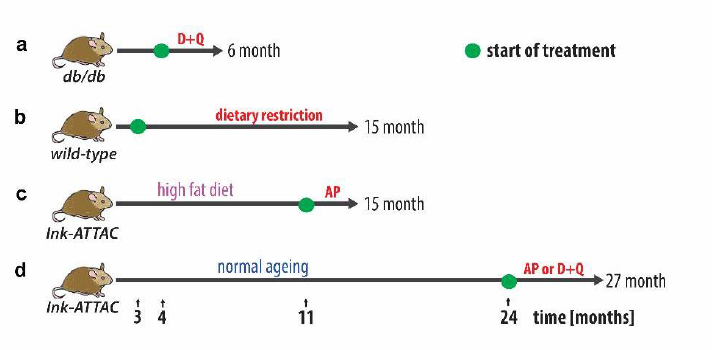
Figure 1: Treatment scheme for obese and ageing animals. (A) db/db mice were treated with D+Q for 2 months until 6 months of age. (B) Wild-type mice underwent several dietary restriction regimes. ( C) Ink-ATTAC mice under high fat diet were treated with AP20187 for 4 months and (D) ageing Ink- ATTAC mice were treated for 3 months wit AP20187 or D+Q.